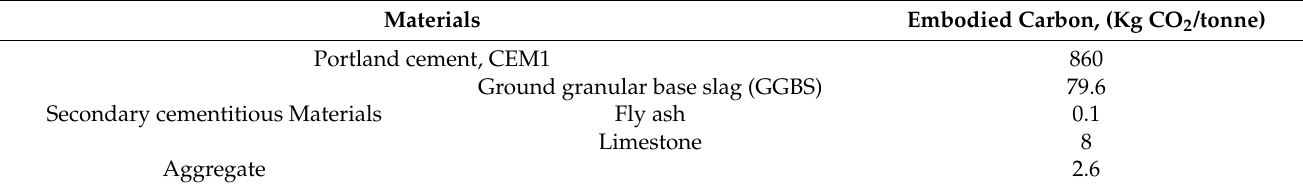
Table 2. Embodied coefficient for LCC Materials